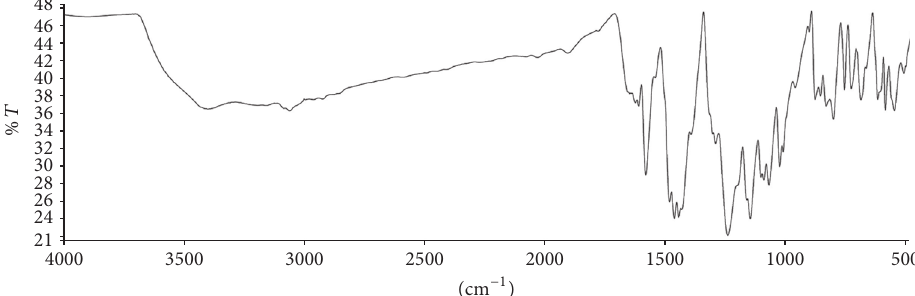
Figure 5: FTIR spectrum of sulfonated poly(arylene ether benzimidazole) copolymer.